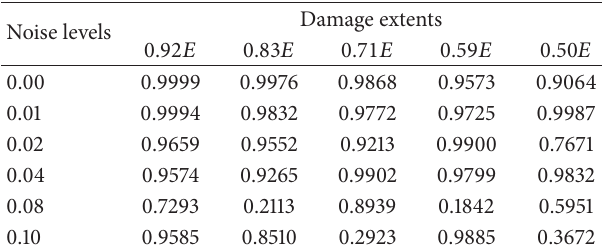
Table 11: The MAC values of acceleration damage parameter vector extracted from the same load case.